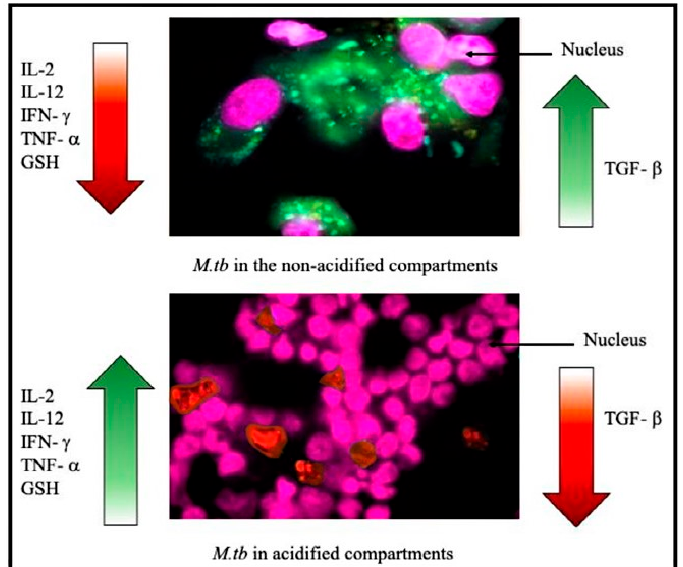
Figure 2. Quantification of M. tb in acidified and non-acidified compartments in granulomas from healthy subjects. M. tb expressing green fluorescent protein.